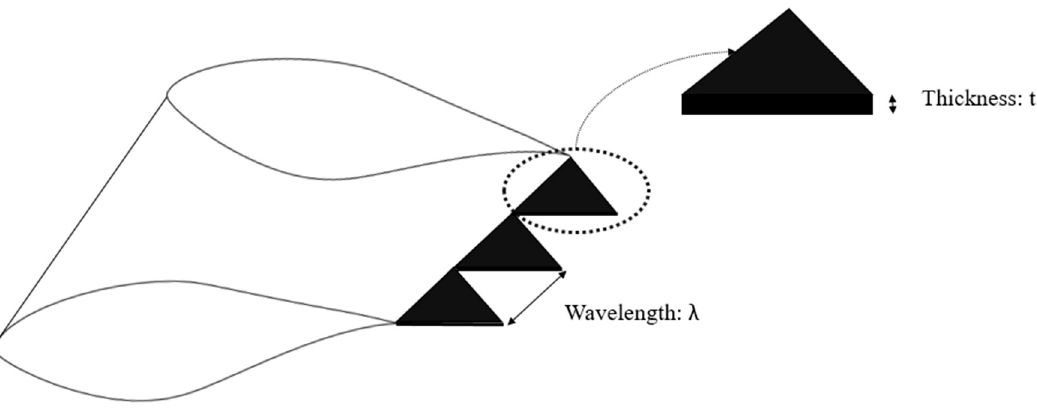
Figure 2. NREL phase Vi wind turbine cross section S809 airfoil with serration extension.